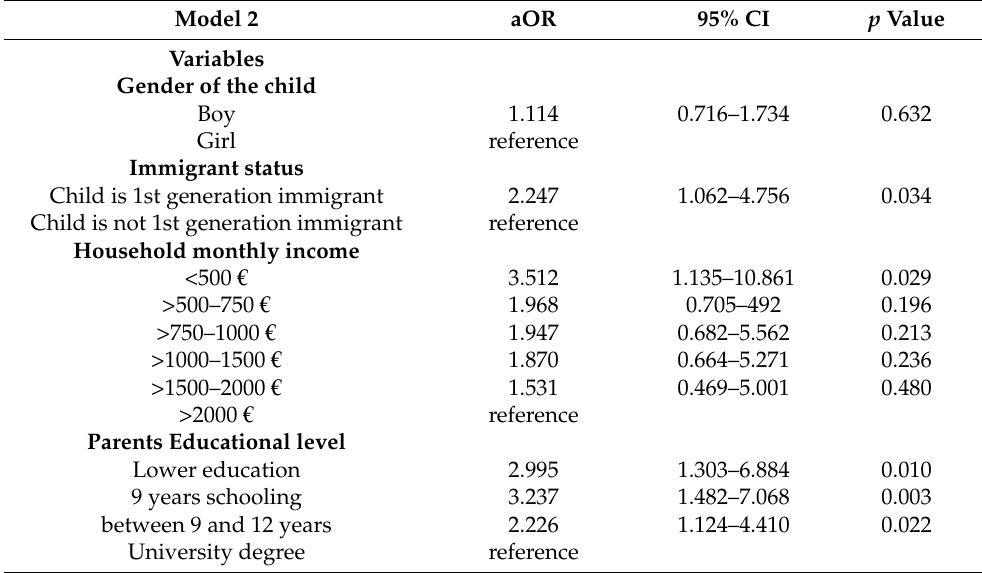
Table 7. Factors associated with the chance of developing emotional and behavioral problems; immigrant status variable: 1st generation immigrant